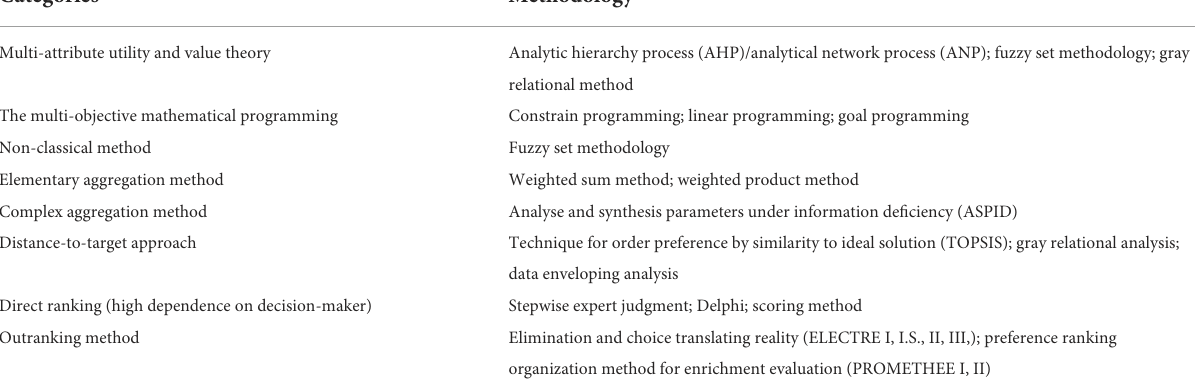
TABLE 2 Categories for classifying multi-criteria decision making methodologies [extracted from